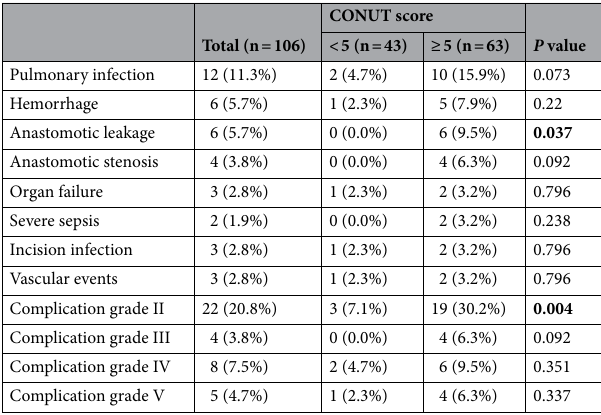
Table 2. Correlation analysis of various complications and the CONUT